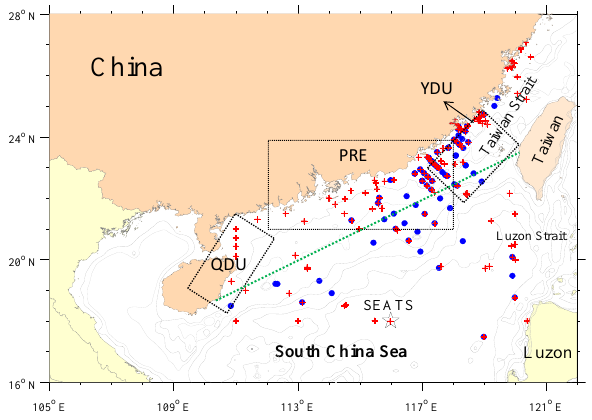
Fig. 2. Map of the study region. QDU and YDU refer to upwelling zones off Qiongdong and Yuedong (boundaries of the zones were defined following Jing et al. (2011)). PRE refers to the Pearl River estuary, and SEATS refers to the Southeast Asian Time-series Study station (18ºN, 116ºE). Blue circles show the locations where concurrent MODIS R rs data and in situ observed Chl were used for algorithm evaluations. Red crosses show the locations where concurrent field measured R rs and Chl were used for algorithm evaluations ， 121 groups of which were collected in the coastal waters (from the green dotted line towards the shore) and were also used for further regional algorithm tuning.